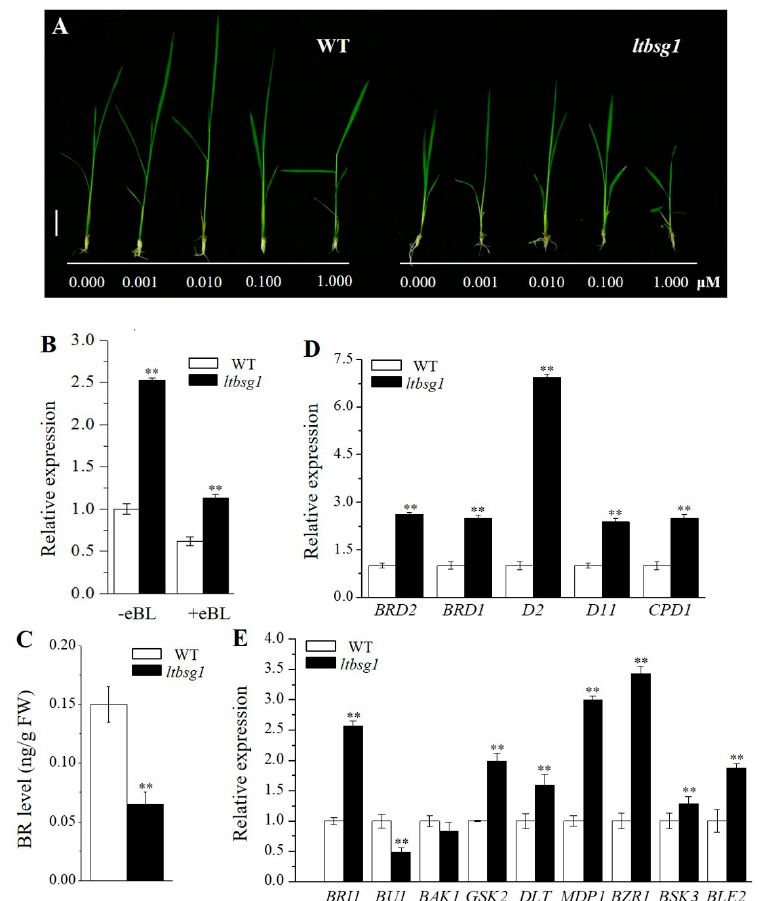
Figure 8. Rescue of the phenotype of mutant ltbsg1 by 24-EBL and the feedback regulation of BR-related genes. ( A ) Phenotypic observation of WT (left) and mutant ltbsg1 (right) at three-leaf stage treated with different doses of 24-EBL (0.000 to 1.000 μ M). Bar = 1.5 cm; ( B ) The expression of LTBSG1 in leaf treated with 0.01 μ M 24-EBL; ( C ) Quantification of endogenous brassinolide contents of WT and mutant ltbsg1 ; ( D ) The expression levels of genes related to BR biosynthesis in young panicles of WT and mutant ltbsg1 ; ( E ) The expression levels of genes related to BR signaling in young panicles of WT and mutant ltbsg1 . The rice OsActin gene was used as an internal control. Values represent the means ± SD of three biological replicates ( n = 3). ** p <